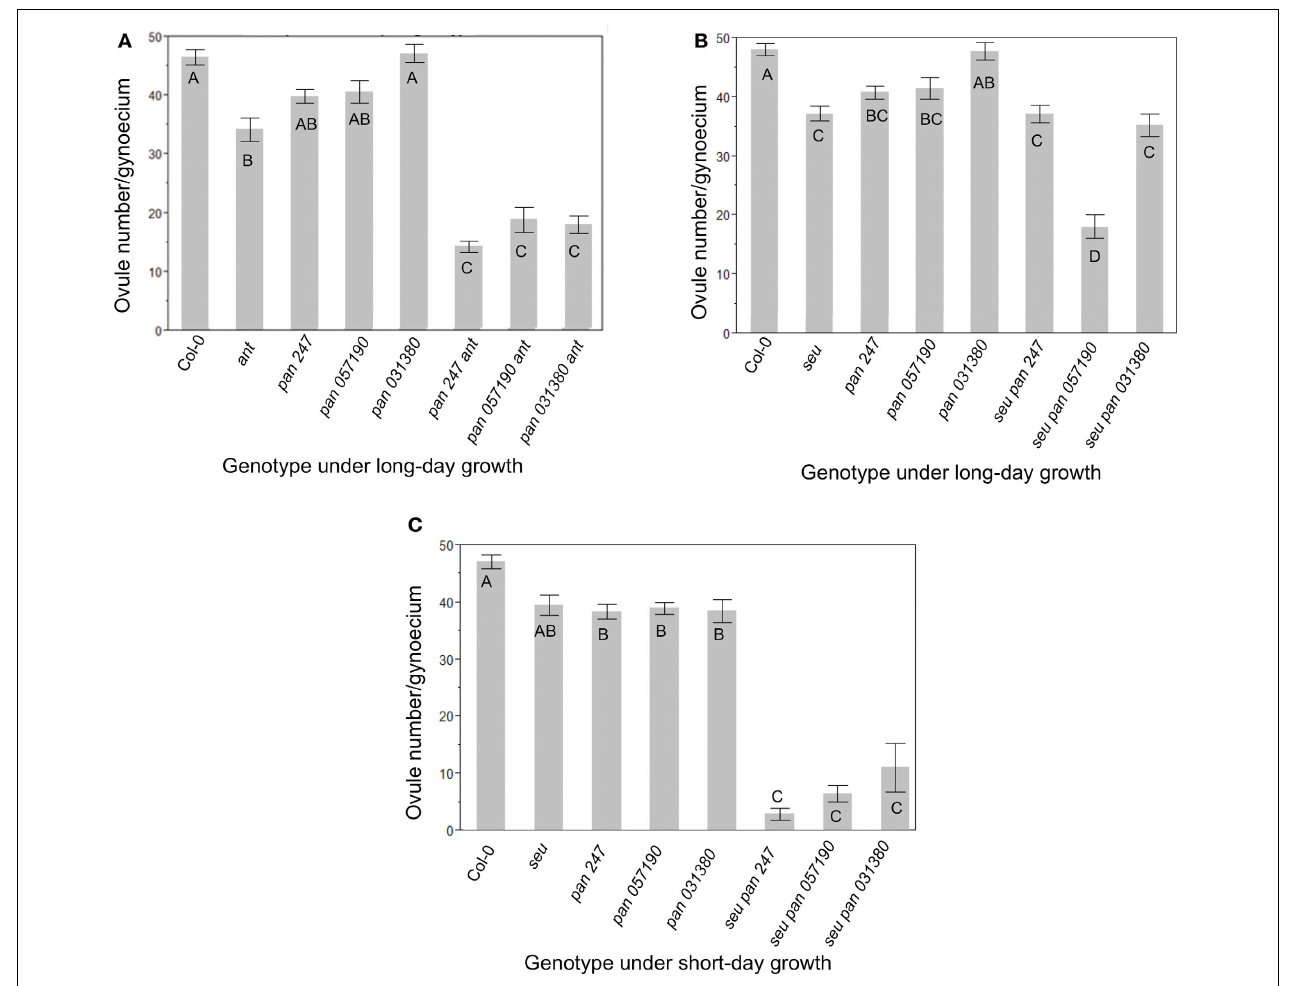
FIGURE 1 | Ovule number is decreased in pan ant and seu pan double mutants. (A) Under long-day growth conditions pan ant double mutants displayed an enhanced loss of ovules relative to single mutant parents for all three pan alleles examined. (B) Under long-day growth conditions only the seu pan 057190 plants showed a statistical reduction in ovule number compared to single mutants parents. (C) Under short-day growth conditions,